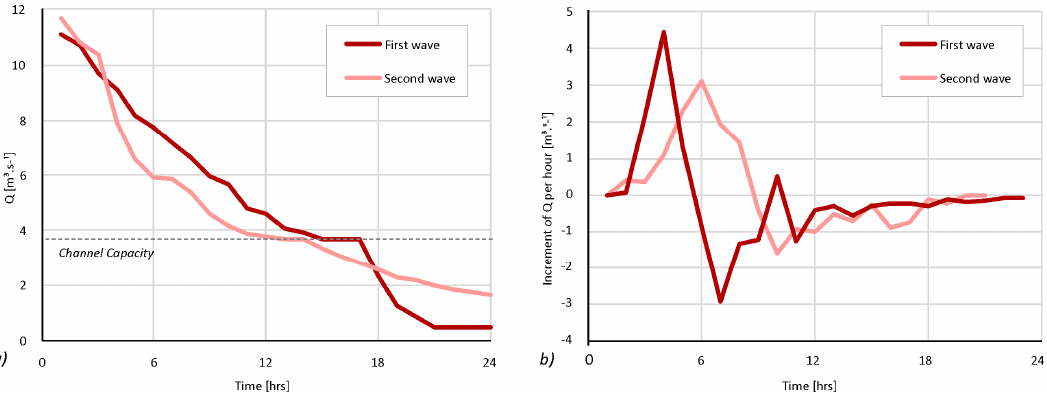
Figure 10. Hydrologic conditions during the reconstructed flood event. ( a ) Increment of discharge per hour; ( b ) duration curve for two waves of the flood event.